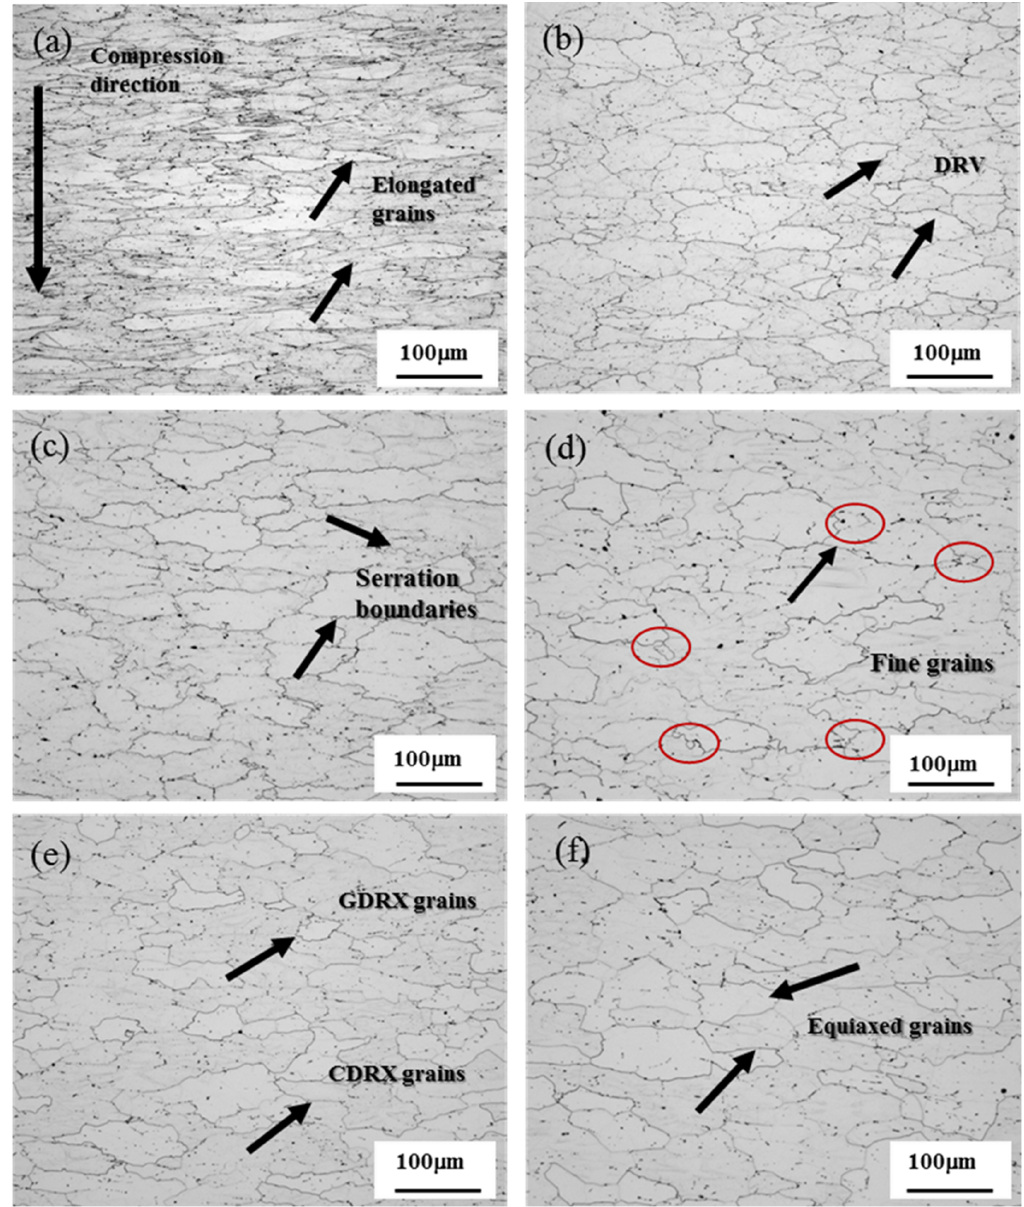
Figure 7. Microstructures of the alloy under different deformation conditions after hot compression: ( a ) 300 °C/10 s −1 , lnZ = 49.44; ( b ) 360 °C/1 s −1 , lnZ = 42.67; ( c ) 420 °C/1 s −1 , lnZ = 38.97; ( d ) 480 °C/0.1 s −1 , ( a ) 300 ◦ C / 10 s − 1 , lnZ = 49.44; ( b ) 360 ◦ C / 1 s − 1 , lnZ = 42.67; ( c ) 420 ◦ C / 1 s − 1 , lnZ = 38.97; ( d ) 480 ◦ C / 0.1 s − 1 , lnZ = 33.56; ( e ) 480 °C/0.01 s −1 , lnZ = 31.26; ( f ) 540 °C/0.01 s −1 , lnZ = 28.61. lnZ = 33.56; ( e ) 480 ◦ C / 0.01 s − 1 , lnZ = 31.26; ( f ) 540 ◦ C / 0.01 s − 1 , lnZ =